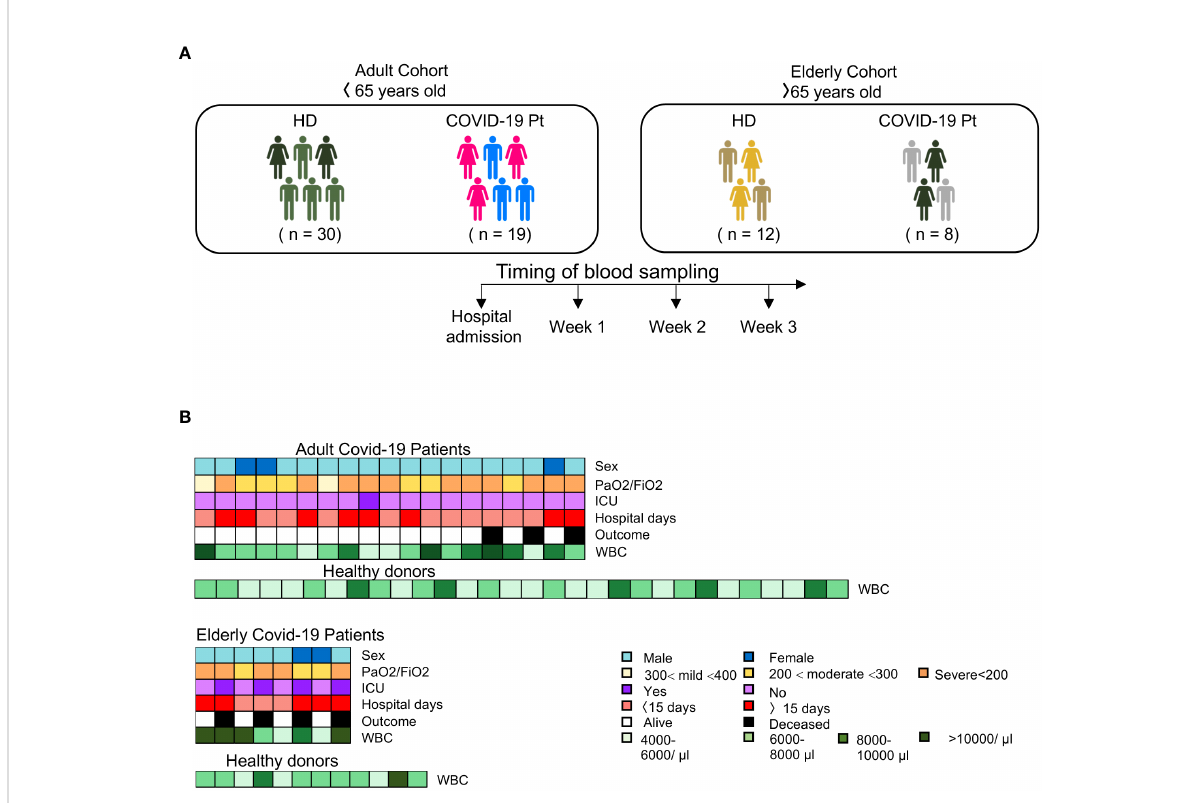
FIGURE 1 Overview of study design. (A) Experimental design and work fl ow of the study. (B) Schematic representation of the major demographic (age and sex) and clinical data [PaO2/FiO2, intensive care unit (ICU), hospital days, white blood count (WBC) and outcome] of patients enrolled in the